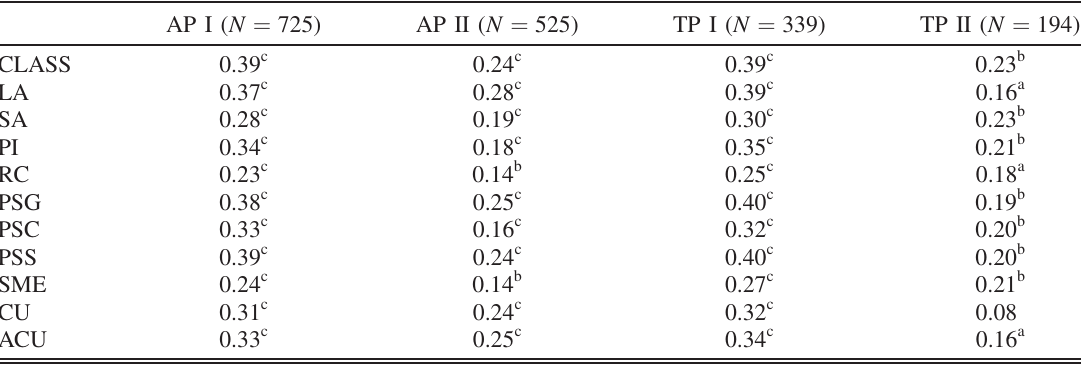
TABLE I. Correlations between prior knowledge and CLASS measures. Superscripts indicate p values. The notations on the table are as follows: Fall Active Physics (AP I); Fall Traditional Physics (TP I); Spring Active Physics (AP II); Spring Traditional Physics (TP II); Learning Approach (LA); Solving Approach (SA); personal interest (PI); real-world connection (RC); problem-solving general (PSG); problem-solving confidence (PSC); problem-solving sophistication (PSS); sense-making effort (SME); conceptual understanding (CU); applied conceptual understanding (ACU). For AP I and TP I, the measure of prior knowledge is the FCI. For AP II and TP II, the measure of prior knowledge is the